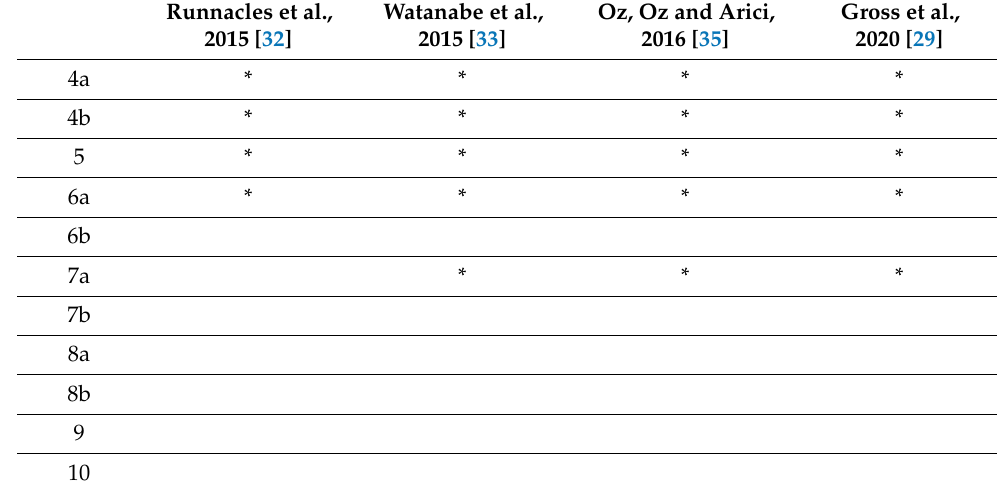
Table 4. Cont. CONSORT Checklist of Items for Reporting a Randomized Trial of Dental Materials Runnacles et